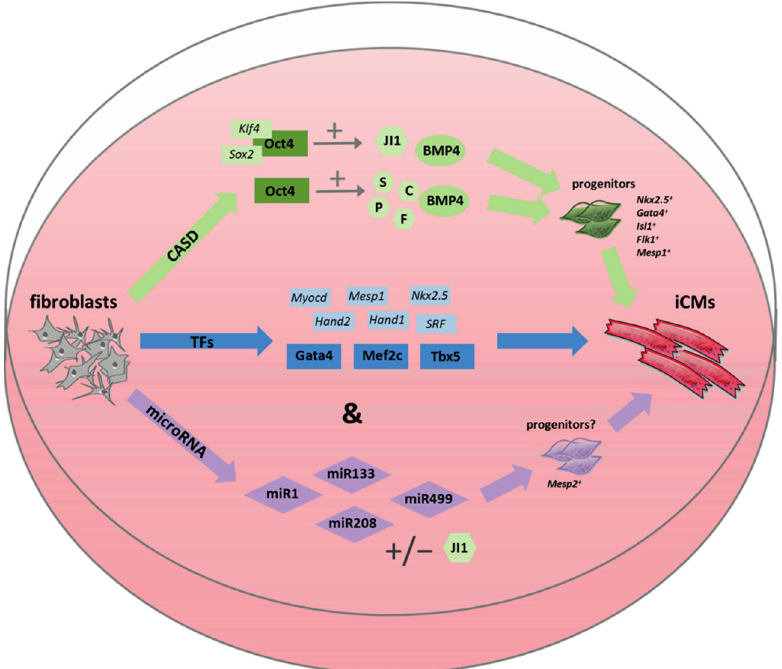
Figure 1. In vitro approaches for direct reprogramming of fibroblasts into induced cardiomyocytes (iCMs). The CASD lineage conversion method tries to directly convert fibroblasts into iCMs by a transient overexpression of pluripotency factors in combination with lineage specific soluble signals. Other, more direct approaches use transcription factors (TFs), microRNAs, or a combination of both (&) to achieve iCMs.